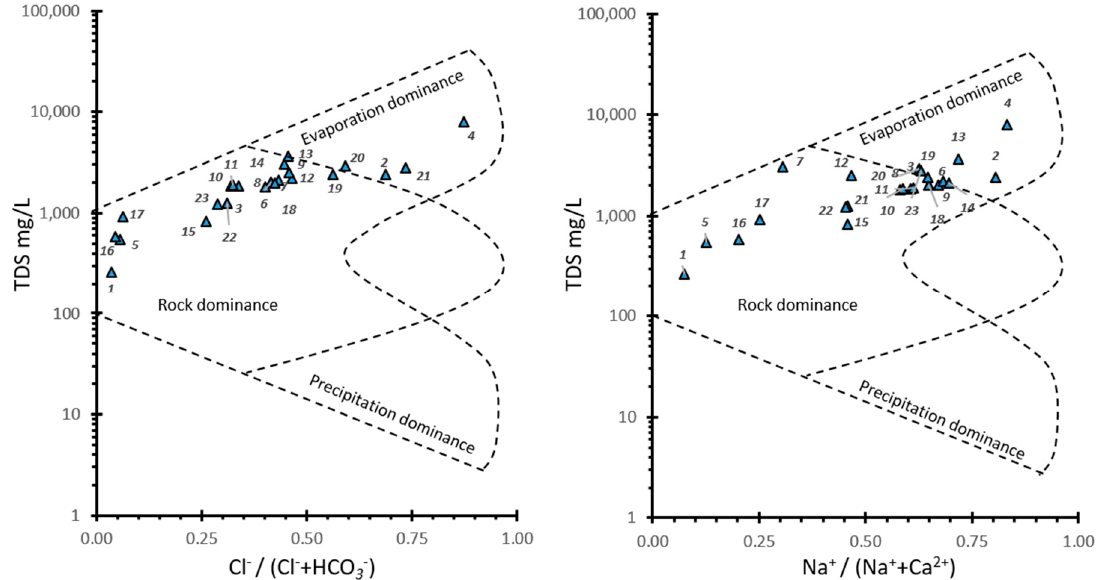
Figure 5. Gibbs diagrams for the concentration composition of major ions in the study area.